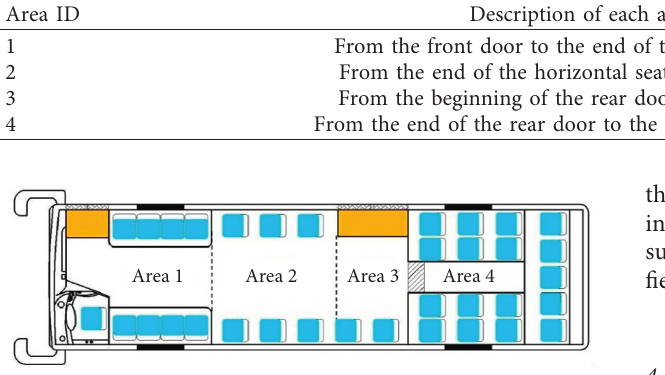
Figure 2: Position of each standing